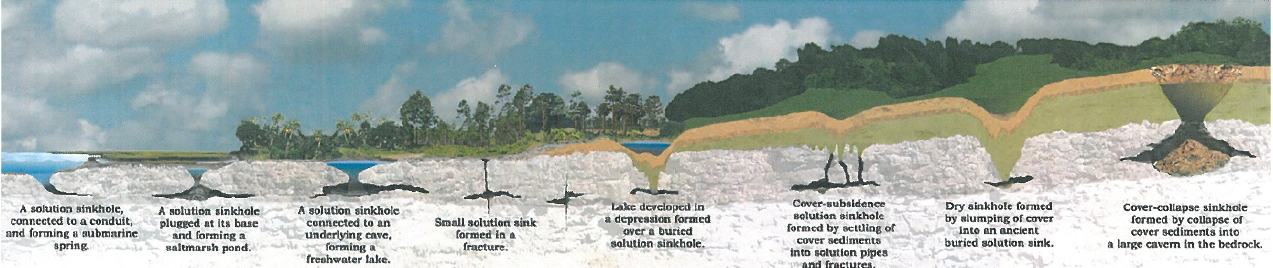
Figure 17. Subsidence dolines and solution dolines of coastal karst, which have various elevation and thus, genetics [98].